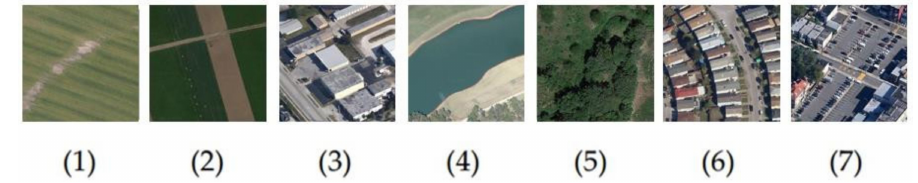
Figure 1. Sample images of RSSCN7 dataset: ( 1 ) grass, ( 2 ) field, ( 3 ) industrial area, ( 4 ) river/lake, ( 5 ) forest, ( 6 ) residential area, and ( 7 ) parking lot.